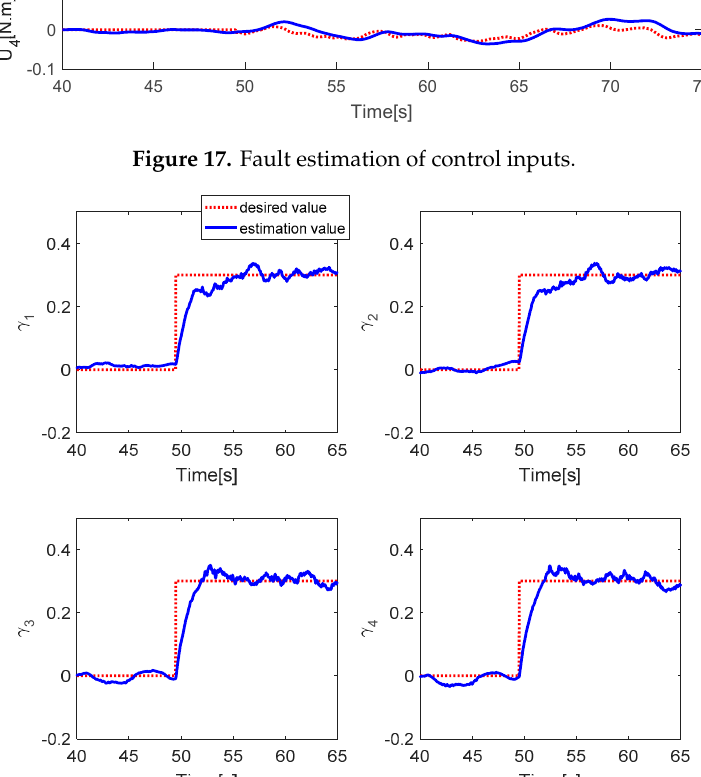
Figure 18. Fault estimation of each actuator.